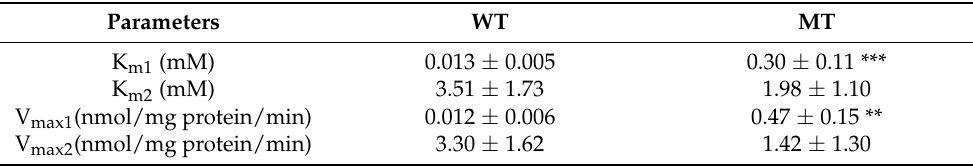
Table 1. Pharmacokinetic parameters of [ 3 H]L-arginine uptake in ALS cell lines.